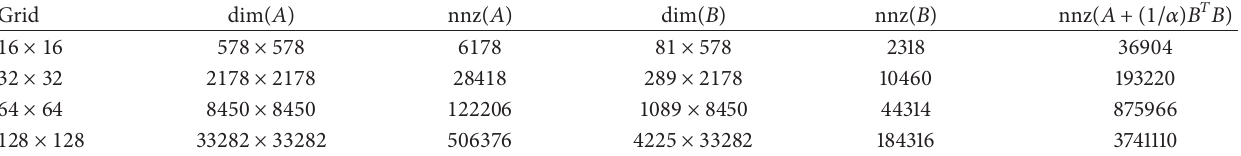
Table 13: Size and number of non-nil elements of the coefficient matrix generalized by using Q2-Q1 FEM in steady Stokes problems.